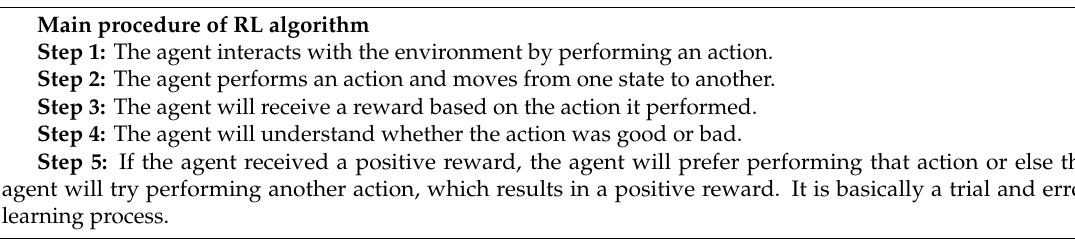
Box 3. Main procedure of RL algorithm.